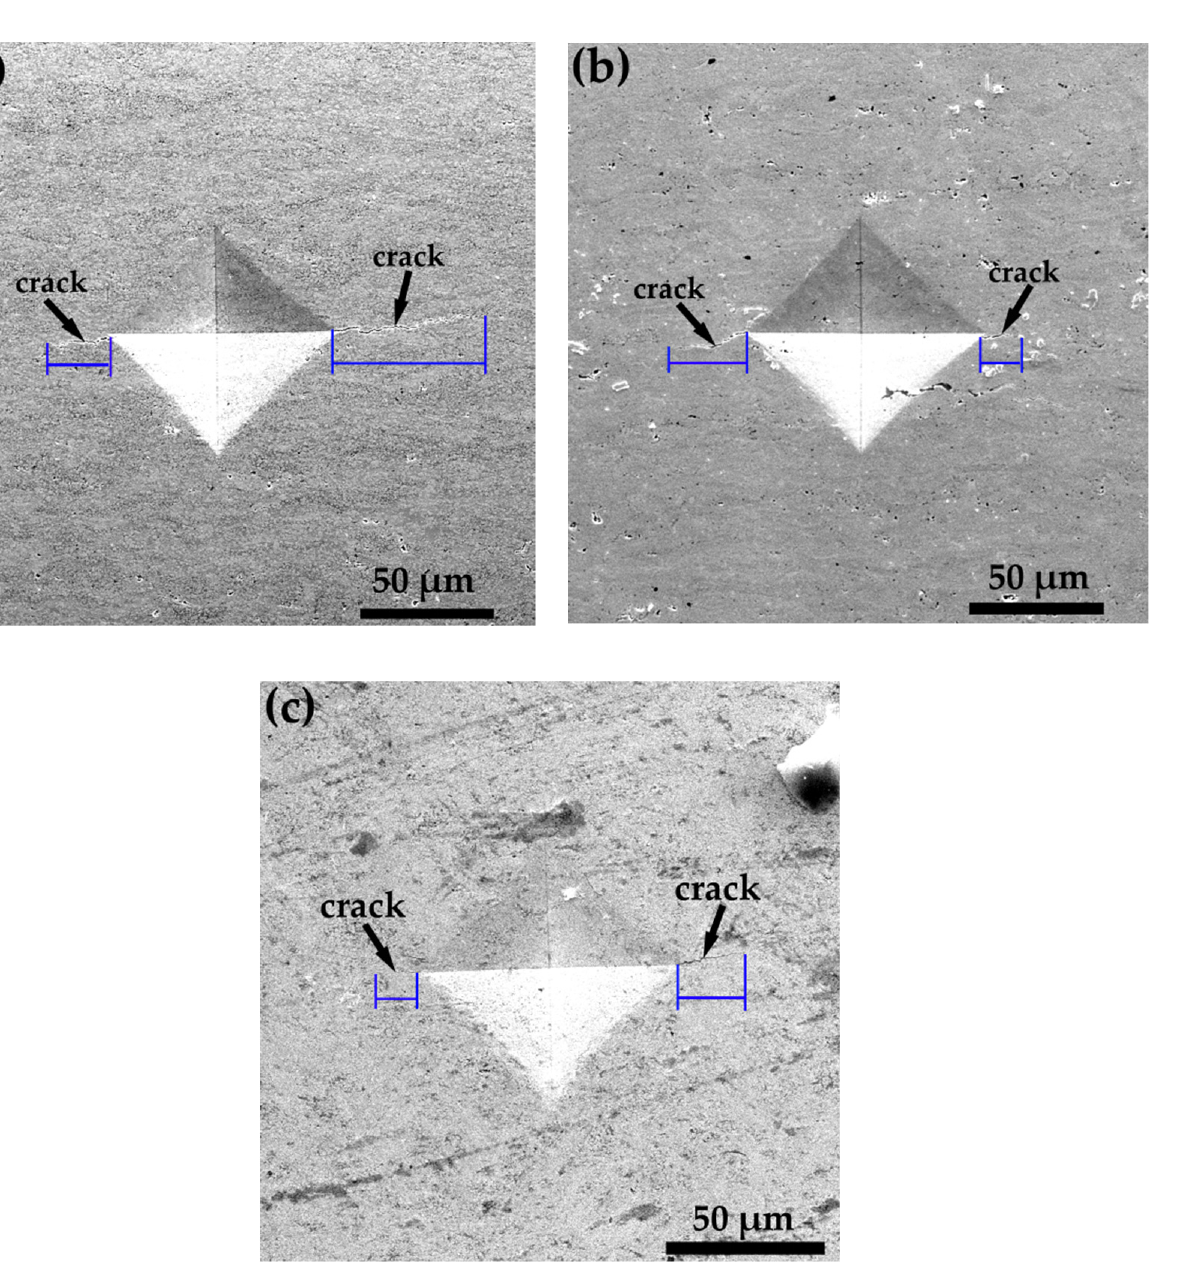
Figure 17. Vickers indentation morphologies of WC-17 coatings formed in various spraying ways ( a ) HVOF, ( b ) WS, ( c ) CS.